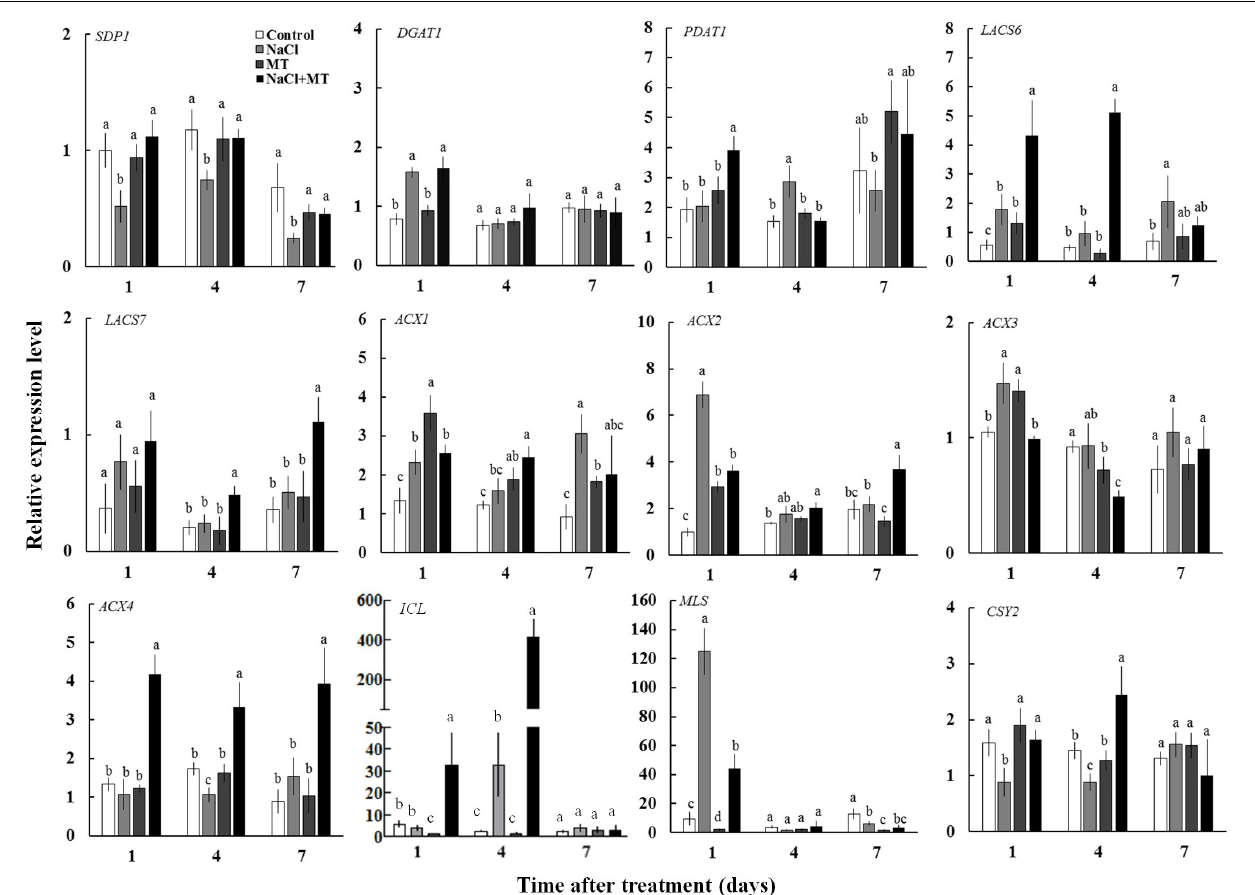
FIGURE 6 | Effects of MT on the expression level of genes related to the TAG synthesis and breakdown, FA β -oxidation, and energy turnover in the leaves of NaCl-stressed or non-stressed Xu 32. Xu 32 seedlings were pretreated with 0.5 µ M (root) + 100 µ M (leaf) MT for 3 days and then subjected to 150 mM NaCl stress. The mature leaves were collected at the same position after 1, 4, and 7 days of NaCl treatment. Each column is the mean of four replications, and columns labeled with different letters indicate significant difference at P <